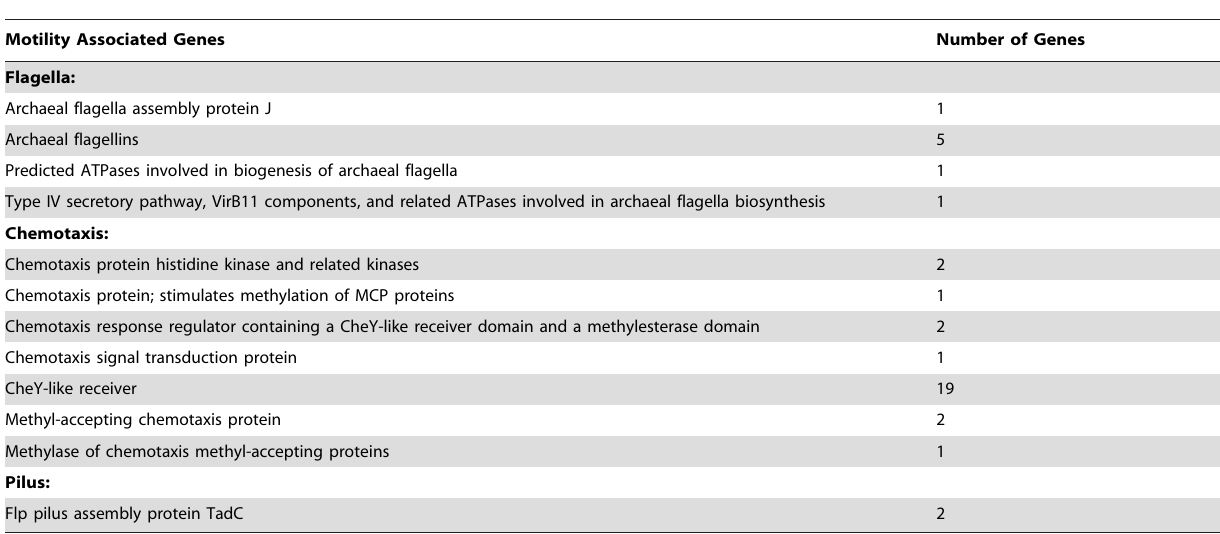
Table 4. N. limnia genes putatively associated with